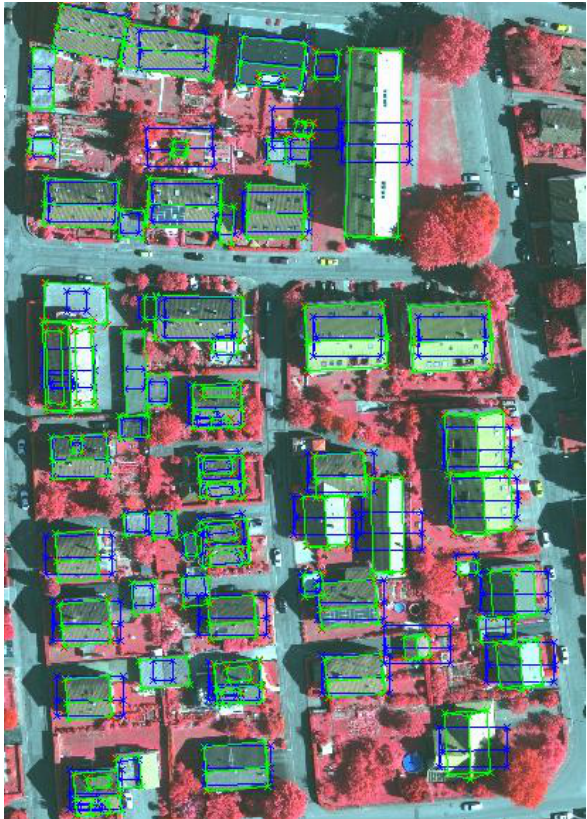
Figure 3. Digital image of the test